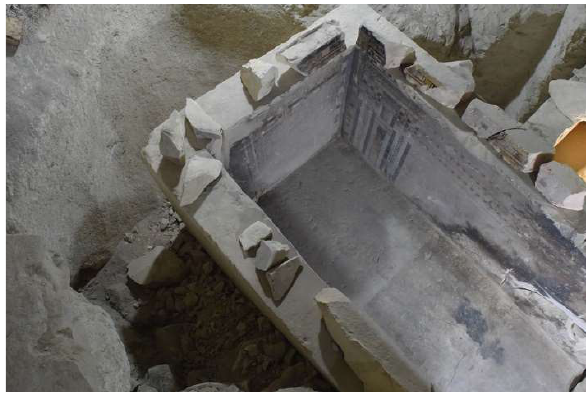
Figure 3. View of Ipi’s